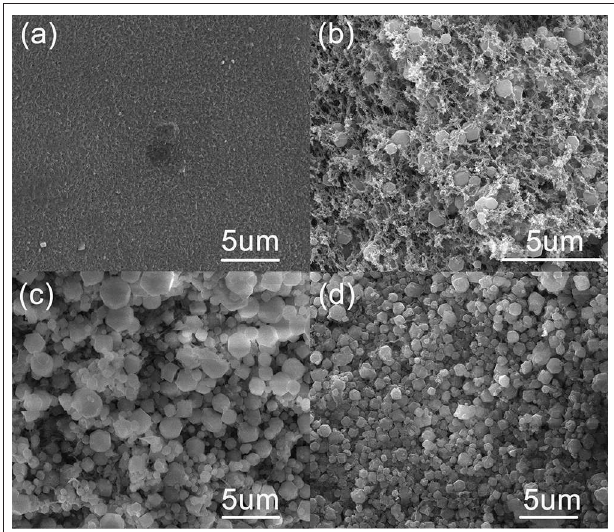
FIGURE 2 | SEM images of CS/ZIF-8 composite beads with different content of ZIF-8. (A) pure CS; (B) CS/ZIF-8–36%; (C) CS/ZIF-8–51%; (D) CS/ZIF-8–60%.